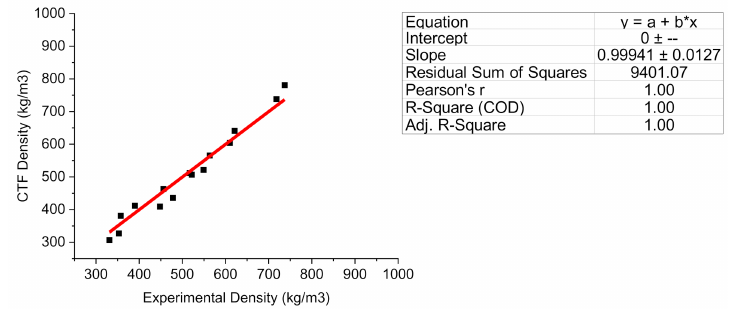
Figure A4. CTF vs. Experimental Density. Differences between the experimental and CTF equilibrium quality and density values at the mentioned axial location are small with no tendency in the estimation of the values.